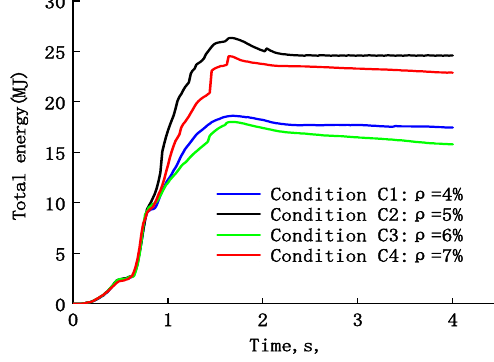
Figure 26. Energy curves of the collision avoidance device.